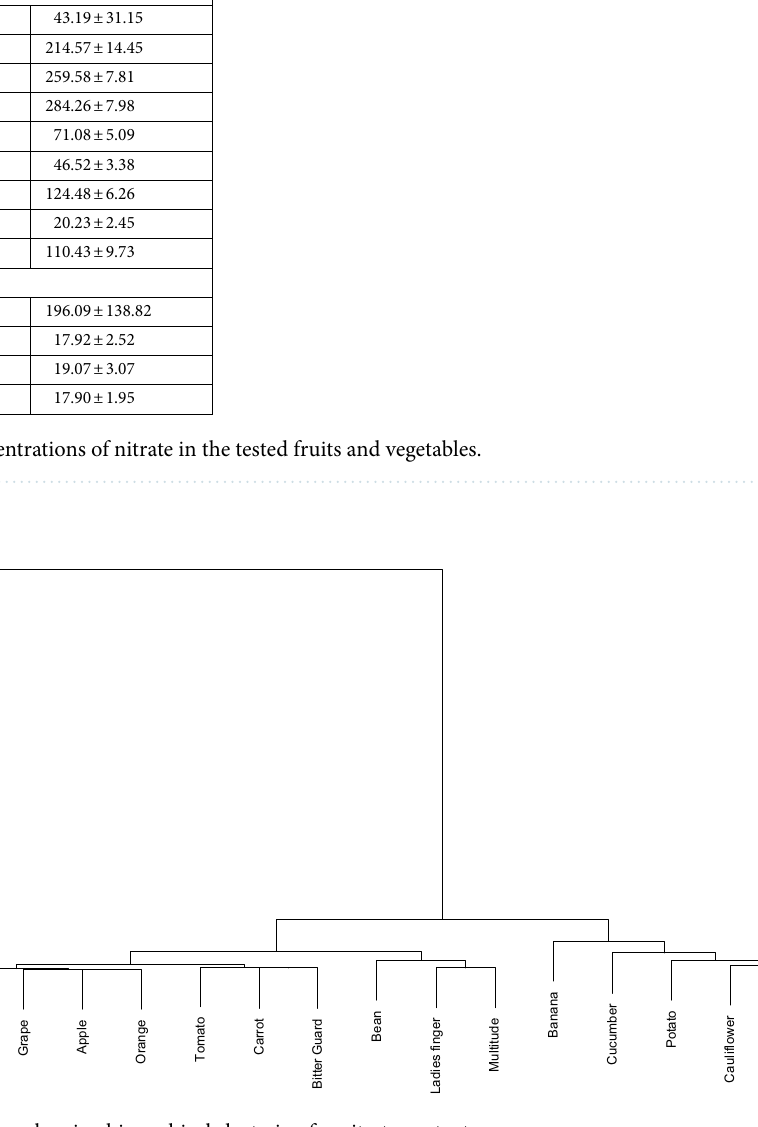
Figure 3. Dendrogram showing hierarchical clustering for nitrate